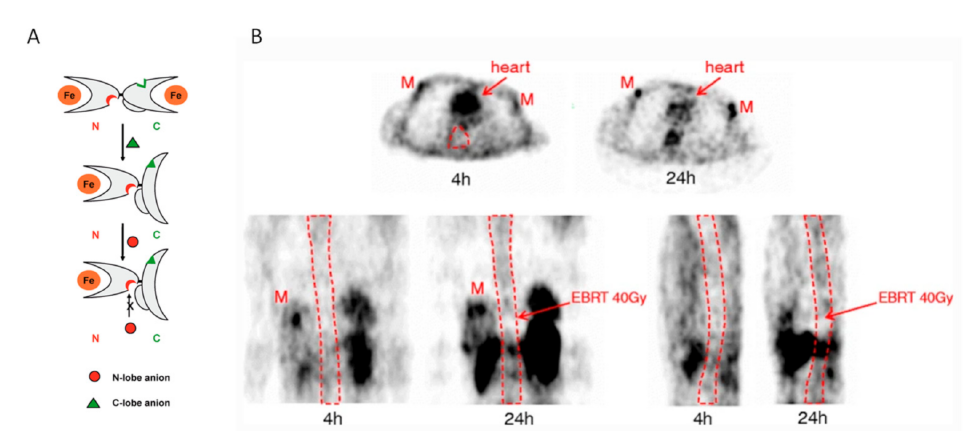
Figure 3. ( A ) Transferrin release mechanism (Reprinted from Ref. [31]) ( B ) 24 h post 86 Y-DOTATOC injection from the 86 Y-SMT-487 clinical trial. Metastases (M) already exhibit a strong uptake 4 h pi, while red marrow activity behaves in phase opposition to the blood pool visible in the heart. Previously irradiated vertebra by EBRT, which has eradicated active marrow, have a similar behavior as the blood pool. Reprinted with permission from Ref. [24]. Copyright 2021